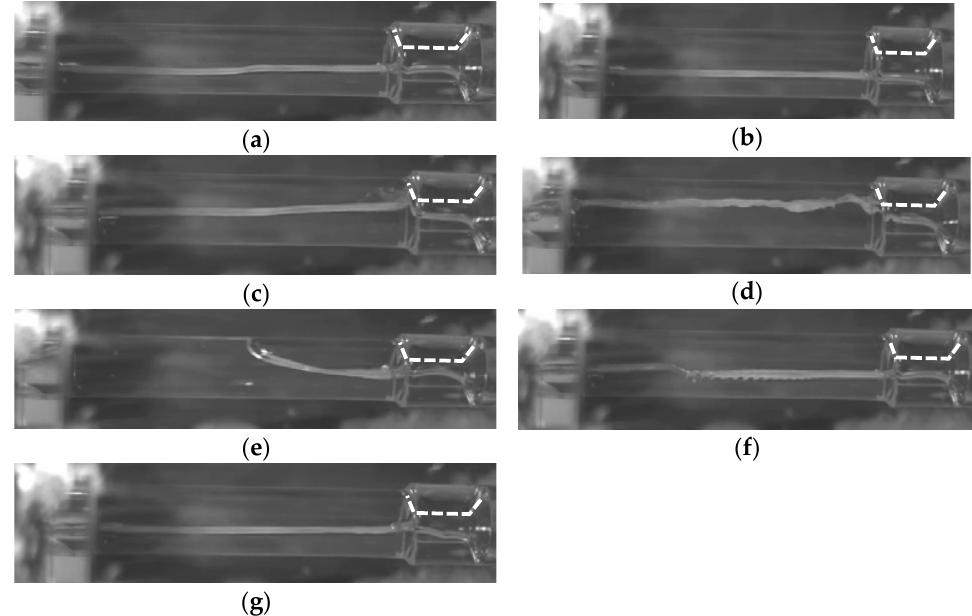
Figure 17. Flow pattern in the horizontal pipe at ( a ) time: 16:10:31.020; ( b ) time: 16:10:32.400; ( c ) time: